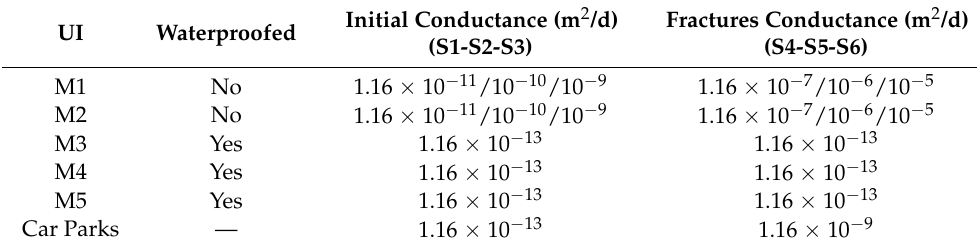
Table 1. Conductance value for all the considered scenarios. Initial Conductance (m 2 UI Waterproofed